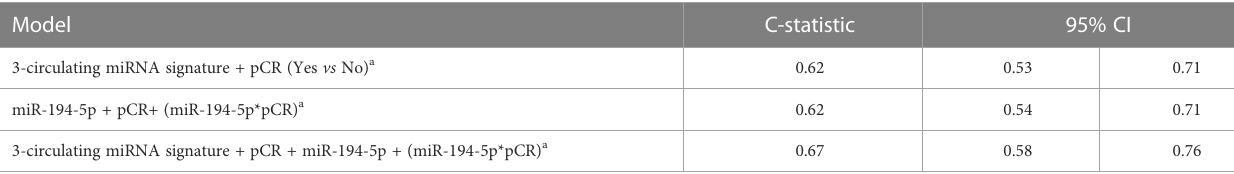
TABLE 3 Prognostic performance of multivariate Cox regression models in the study cohort.